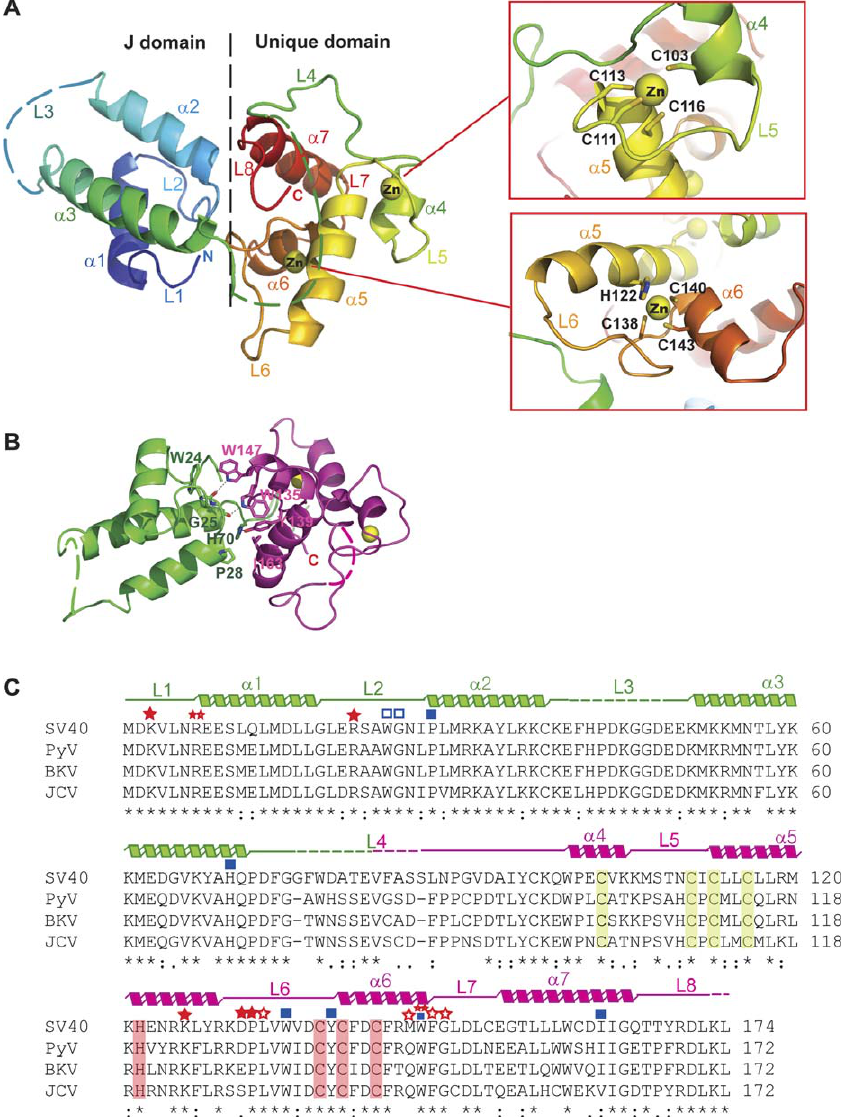
Figure 2. Structure of SV40 Small t Antigen (A) Structural organization of SV40 ST and the zinc coordination of ST unique domain. The peptide chain is color-coded from blue to red, going through the rainbow colors, from the N terminus (blue) to the C terminus (red). (B) Interface of the J and unique domains. The J and unique domains are in green and pink, respectively. Key residues in the interface between the J domain and the unique domain—Trp24, Gly25, Pro28, His70, Trp135, Tyr139, Trp147, and Ile163—are labeled. (C) Sequence alignment of ST proteins from SV40 (strain VA45-54-2), baboon polyomavirus (PyV), BK polyomavirus (BKV), and JC polyomavirus (JCV). Sequence conservation is indicated below the aligned sequences. Secondary structures in the determined crystal structure are indicated above the aligned sequences. Solid and empty stars indicate residues interacting with PP2A A subunit using side-chain and main-chain, respectively. Solid and empty squares represent residues involved in interactions between the J domain and the unique domain with side-chain and main-chain atoms,